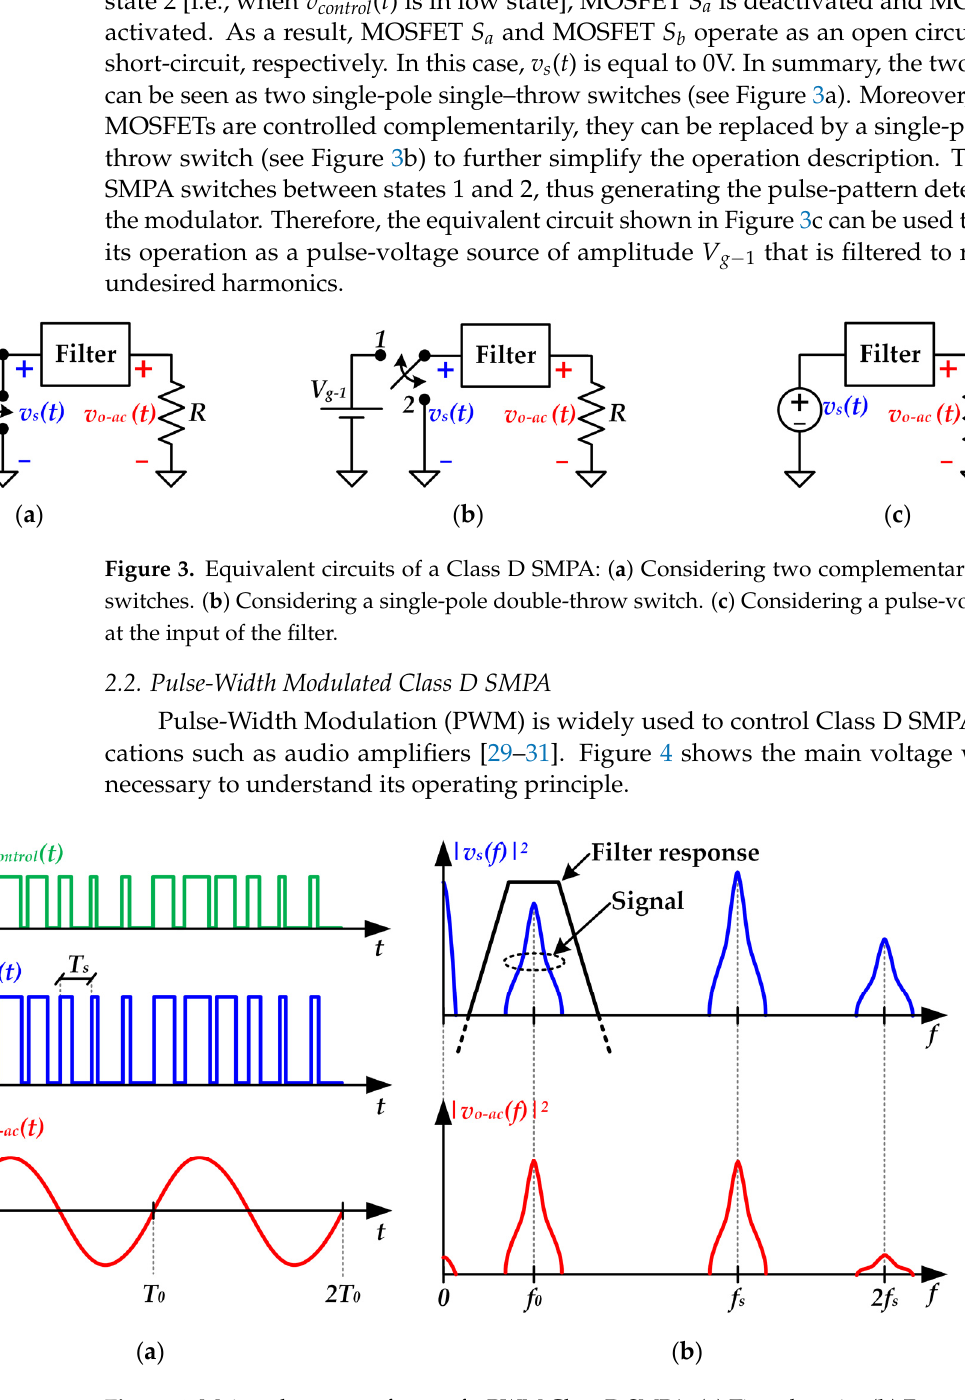
Figure 4. Main voltage waveforms of a PWM Class D SMPA: ( a ) Time domain. ( b ) Frequency do- main. Note that T s and T 0 are the switching period (i.e., 1/f s ) and the communication carrier period (i.e., 1/f 0 ), respectively.